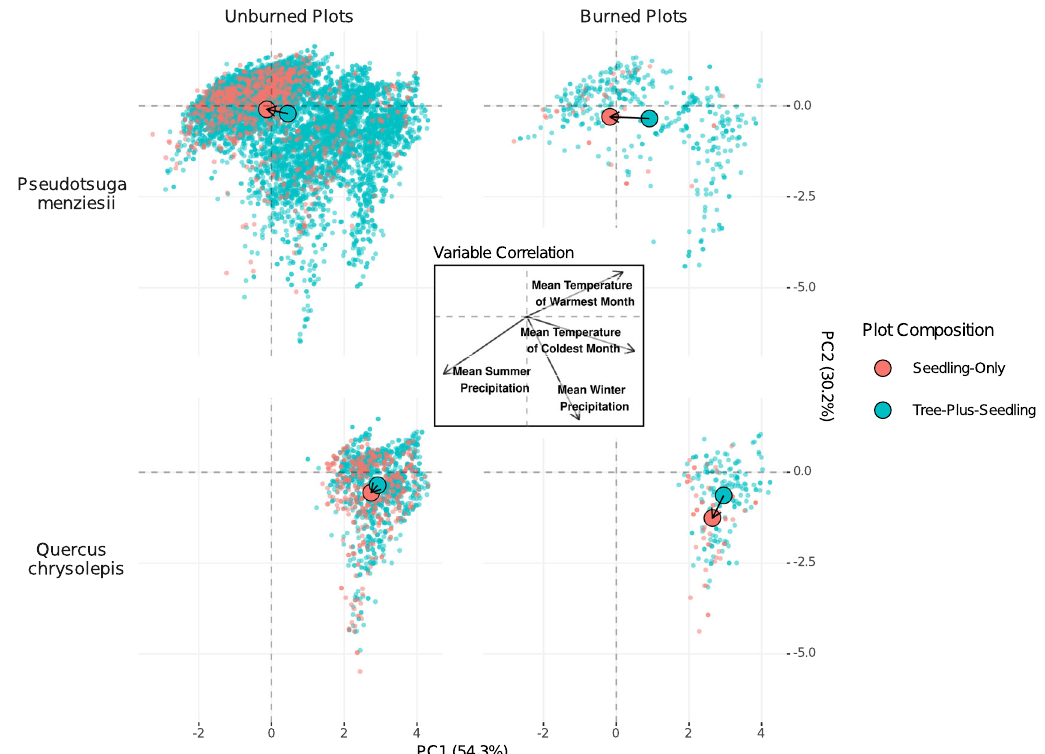
Fig. 3 PCA of Climatic Niche Differences for Pseudotsuga menziesii and Quercus chrysolepis . PCA plot of the climatic niches of seedling-only and tree- plus-seedling plots of the two species where SORD is greater in burned areas (Table 2). PC1 and PC2 explain 84.5% of the variation across all 4 climate variables. Centroids are shown as large points. Similar PCA plots for all species can be found in Supplementary Fig. 1. Source data are provided as a Source Data fi